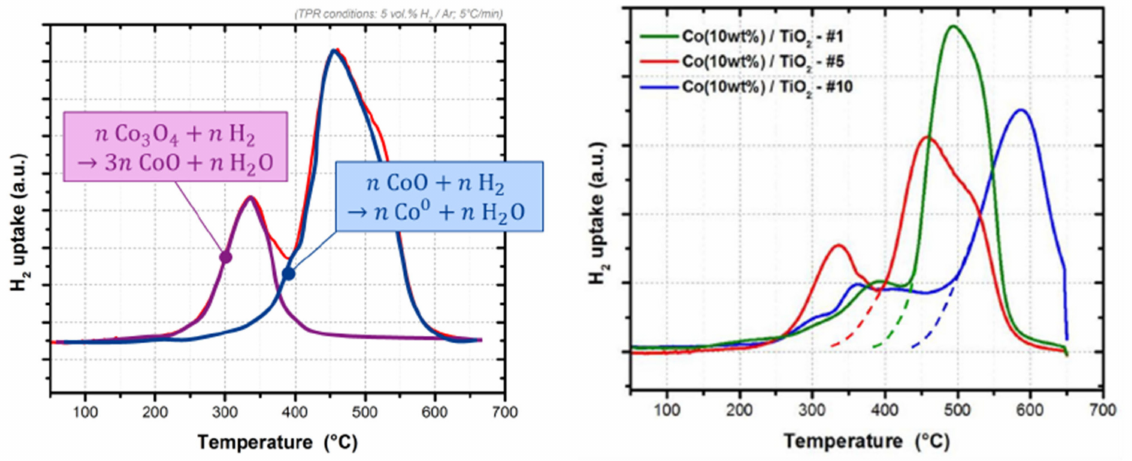
Figure 3. TPR experiment with two-step reduction of cobalt oxide (left). TPR experiments of cobalt oxide reduction on different support materials (right).